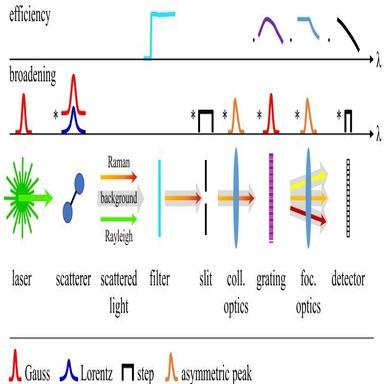
Schematic signal formation for Raman spectroscopy: from signal excitation to signal detection. On the top, spectral efficiency curves (individual influences are multiplied) and shapes of signal broadening influences (individual influences are convolved for each peak) of the corresponding components and processes are given qualitatively.